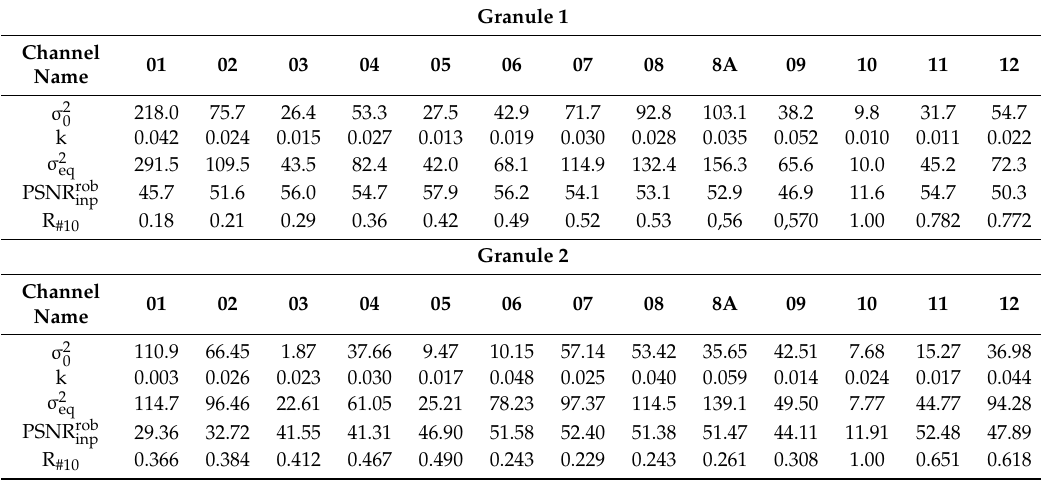
Table 1. Noise parameters in component images of Sentinel-2. PSNR—peak signal-to-noise ratio. Granule 1